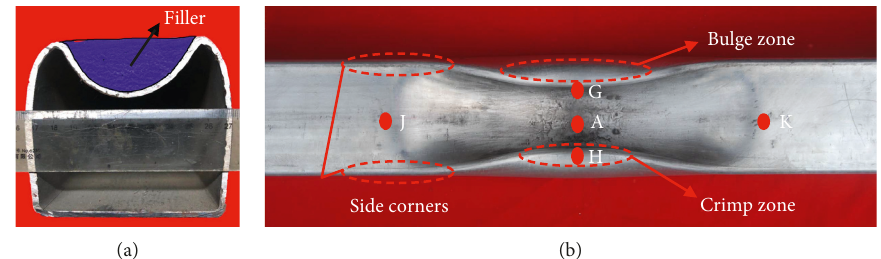
Figure 4: Description of the measurement methods and plastic hinge of square tube deformation. (a) Measurement methods. (b) Plastic